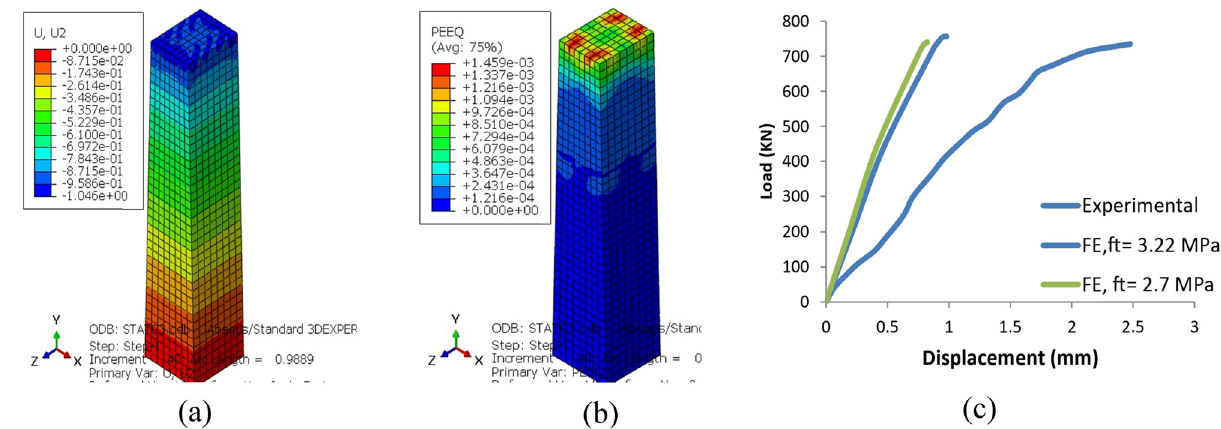
Figure 13: ( a ) Axial deformation at the last load increment, and ( b ) equivalent plastic strain, and ( c ) load – displacement